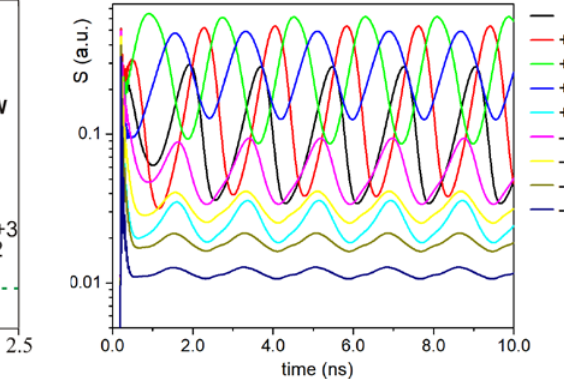
Figure 4. Regions of different laser behavior in the plane of two parameters.